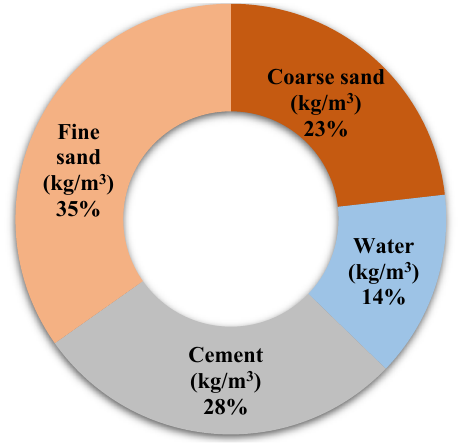
Figure 1. Composition of the reference mortar (RM) (kg/m 3 ).